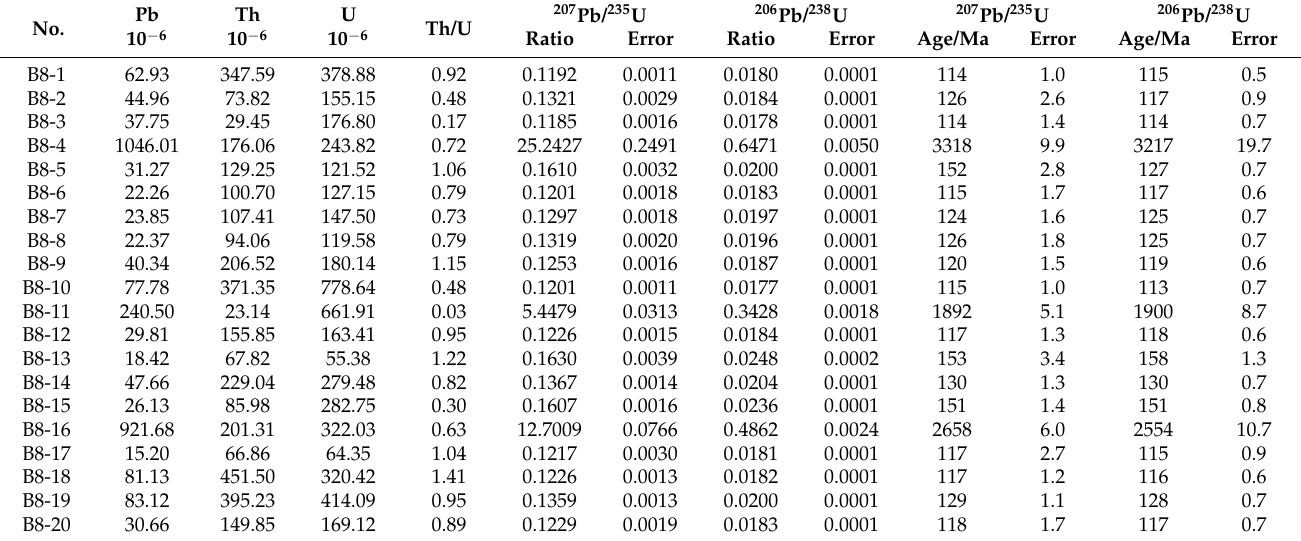
Figure 5. The CL image and the zircon U-Pb concordance diagram of zircon in the Zhouguan granodiorite. Table 3. LA-MC-ICP-MS zircon U-Pb dating results of Zhouguan